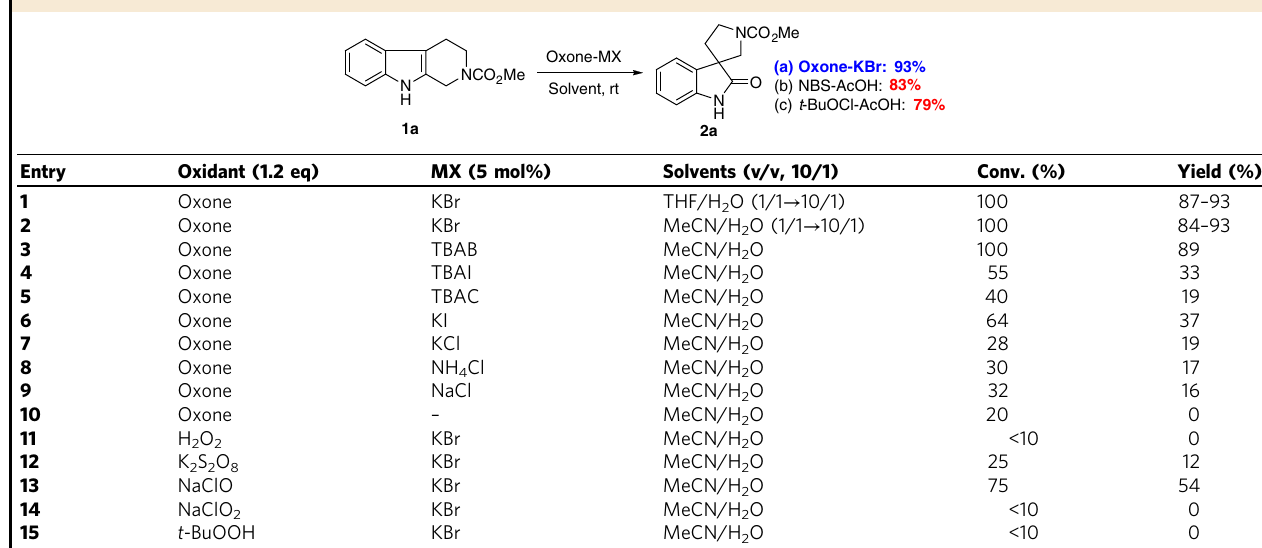
Table 1 Selected conditions for oxidative rearrangement of THC 1a